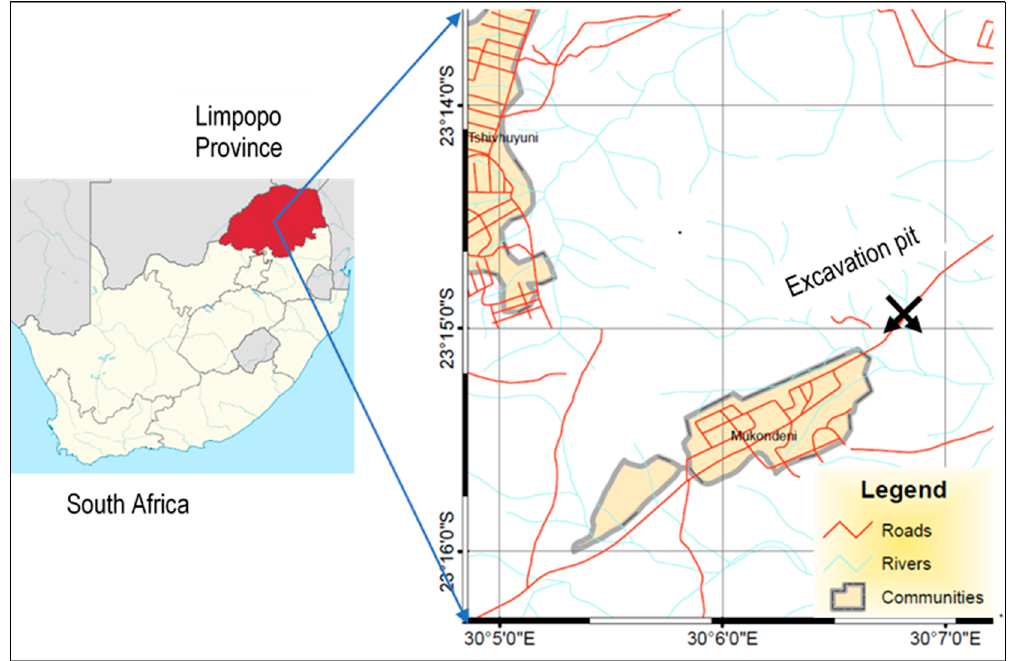
Figure 1. Location of study area; inset, situation of Limpopo in South Africa. (Modified from [27]).